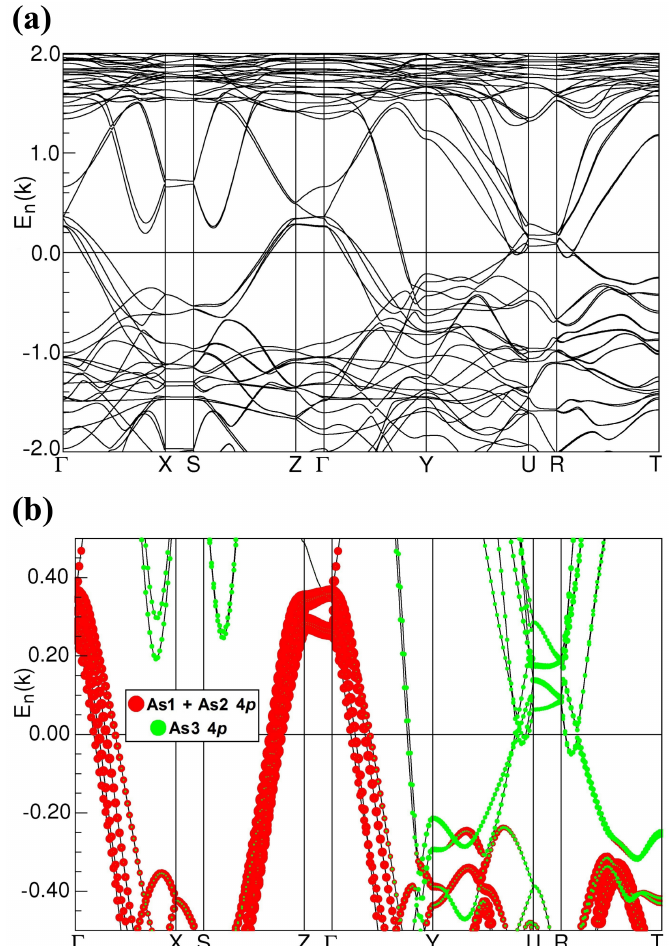
Figure 14. ( a ) The LSDA+U (local spin density approximation) (U = 6 eV) electronic band structure of the AFM (antiferromagnetic) ground state of CeAgAs 2 along high-symmetry lines in the orthorhombic BZ (Brillouin zone). ( b ) The corresponding As 4 p orbital contributions to the electronic bands (band weights) originating from different As sites in the vicinity of E F (zero